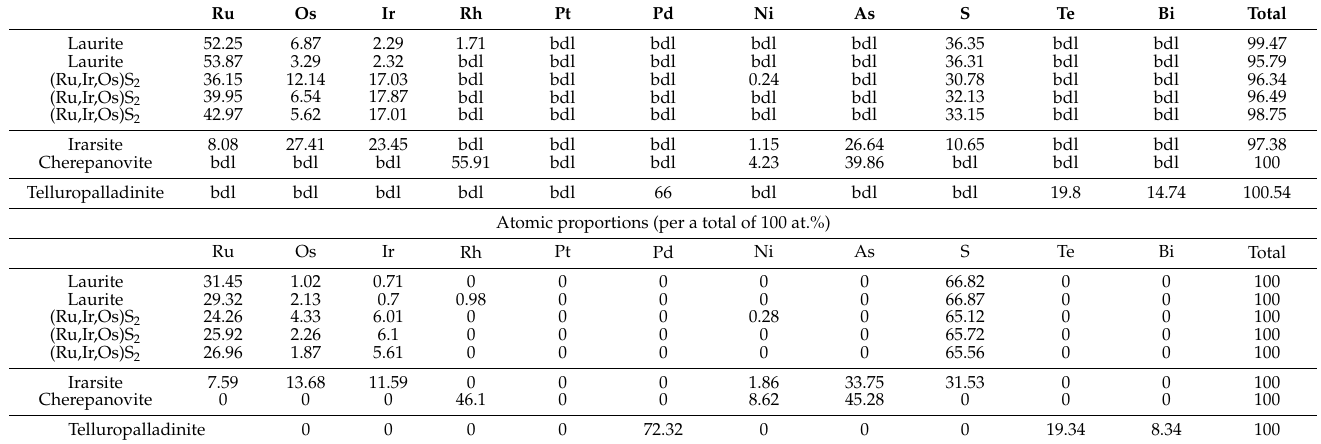
Table 3. Compositions of inclusions PGM in grains of Ru-Os-Ir alloy minerals from the placer of the Kitoy River.